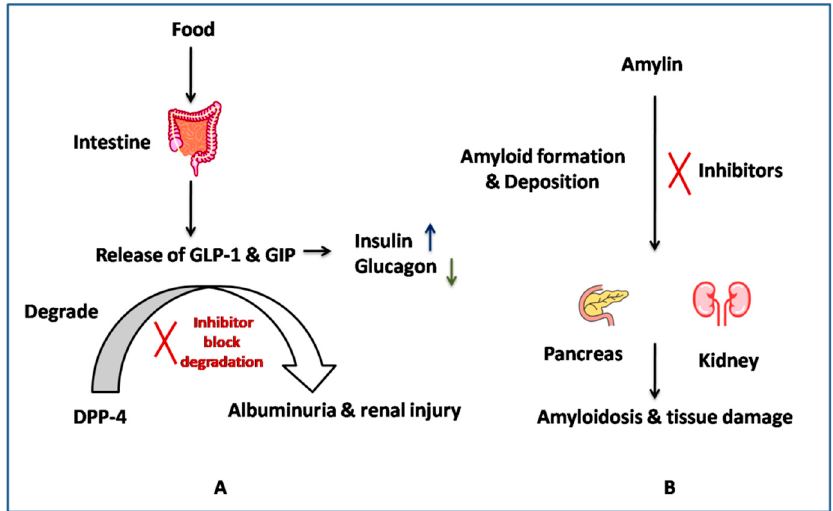
Figure 1. Action mechanism of ( A ) DPP-4, ( B ) Amylin inhibitors.